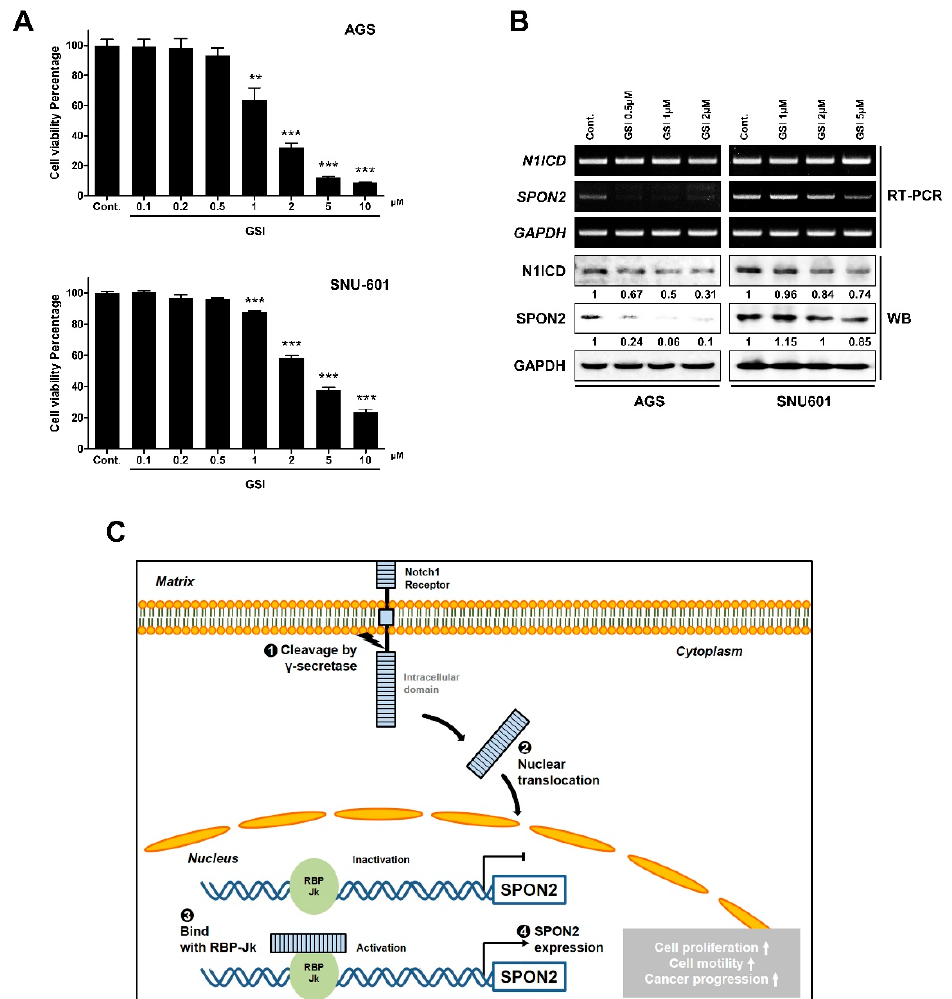
Figure 7. SPON2 expression levels are regulated on inhibiting Notch signaling pathway in AGS and SNU-601 cells. ( A ) Cell viability of AGS and SNU-601 cells after 24 h treatment with γ -secretase inhibitor (GSI) (0.1, 0.2, 0.5, 1, 2, 5, and 10 µ M) was detected by WST-1 assay. Control was treated with 0.1% dimethyl sulfoxide (DMSO). Data are presented as mean ± SEM ( n = 5). p -values were calculated using Student’s t -test, and significant di ff erences are indicated by * (** p < 0.01, *** p < 0.001). ( B ) mRNA and protein expression levels of SPON2 and N1ICD in AGS and SNU-601 cells on GSI treatment were detected by RT-PCR and Western blot analysis. ( C ) Schematic model of regulatory mechanism of SPON2 expression through Notch signaling pathway. Activated N1ICD via γ -secretase translocates in nucleus and binds with RBP-Jk in SPON2 promoter region. Subsequently, SPON2 regulates gastric cancer cell proliferation, migration, and invasion.